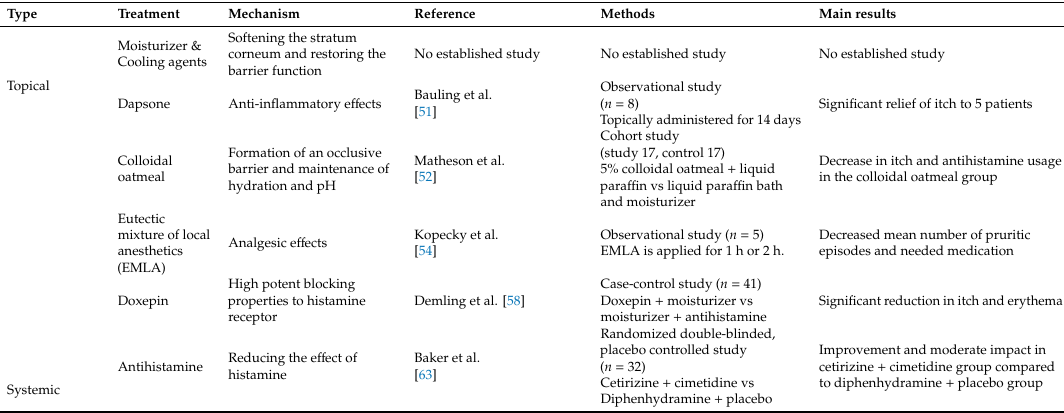
Table 2. Treatments for post-burn